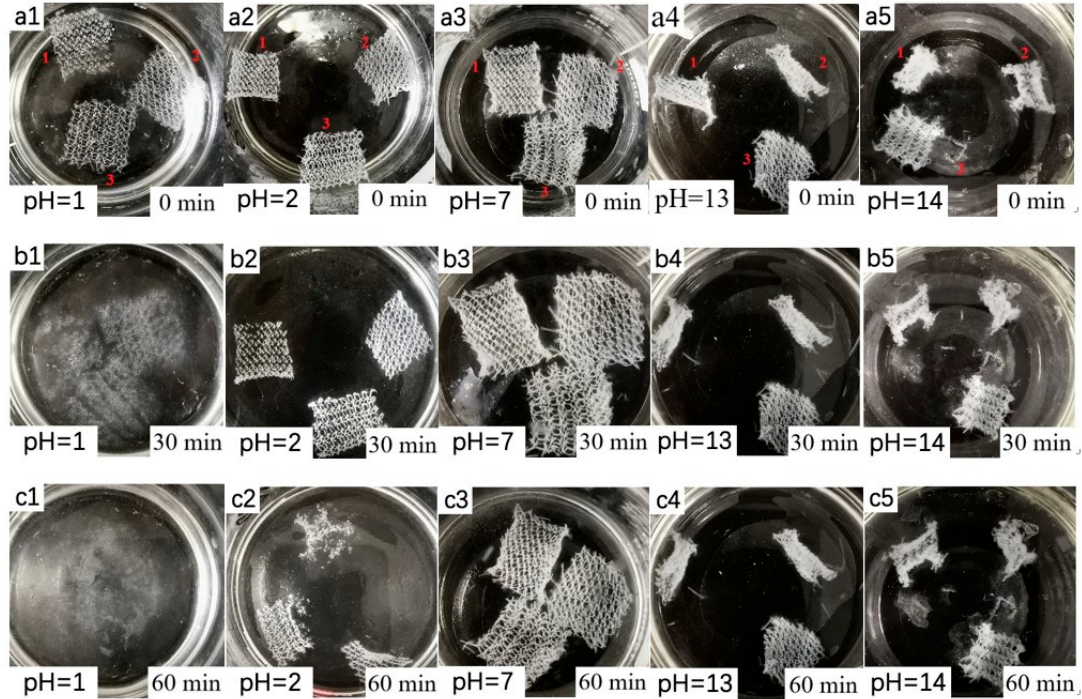
Figure 6. Images of three fabrics treated in ( a1 , a2 ) acid solution, ( a3 ) ultrapure water, and ( a4 , a5 ) aqueous alkali at the beginning; three fabrics treated in ( b1 , b2 ) acid solution, ( b3 ) ultrapure water, and ( b4 , b5 ) aqueous alkali after soaking for half an hour; three fabrics treated in ( c1 , c2 ) acid solution, ( c3 ) ultrapure water, and ( c4 , c5 ) aqueous alkali after soaking for an